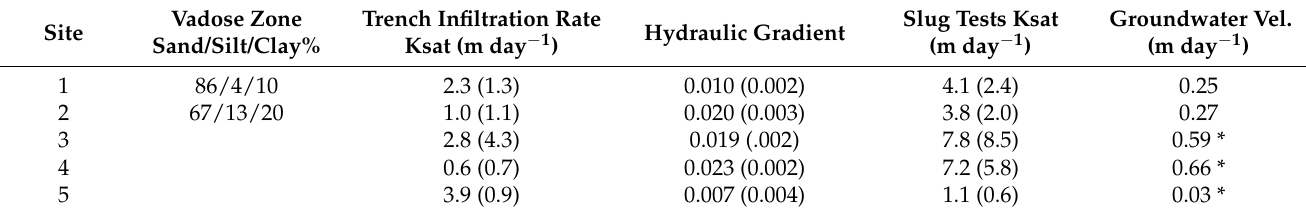
Table 2. Characteristics of soil, aquifer material, and groundwater at Sites